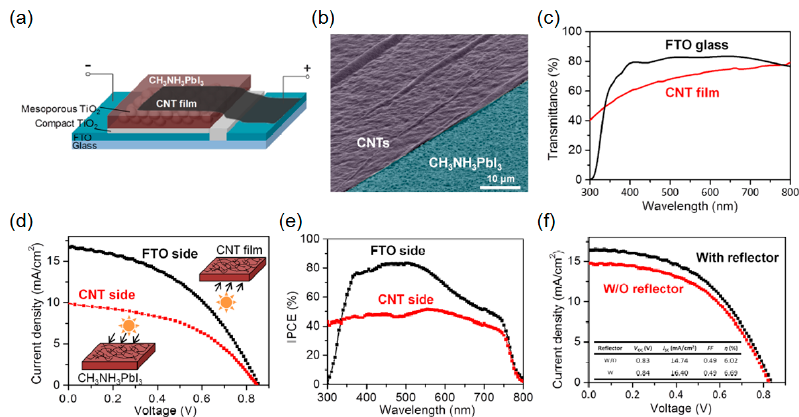
Figure 4. ( a ) Schematic diagram of CH 3 NH 3 PbI 3 perovskite solar cell with carbon nanotube (CNT) film electrode. ( b ) Tilted SEM image of CH 3 NH 3 PbI 3 perovskite substrate (blue) partly covered by CNT